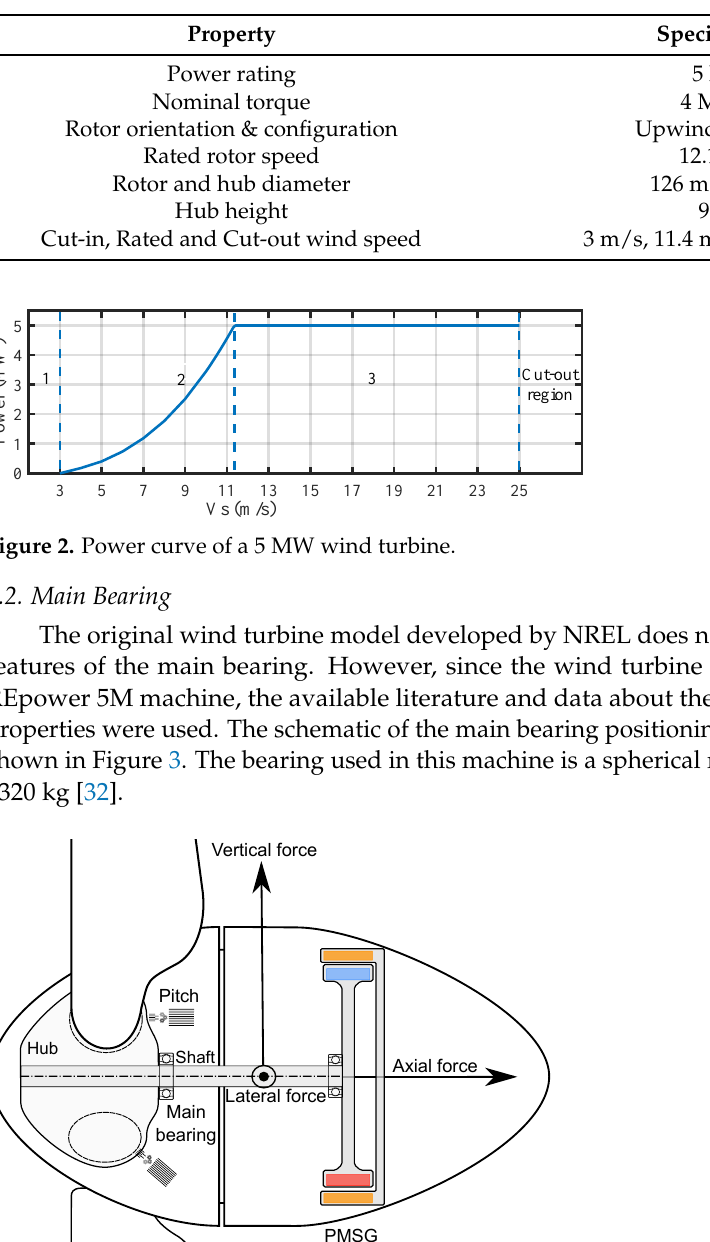
Table 1. Wind turbine properties.